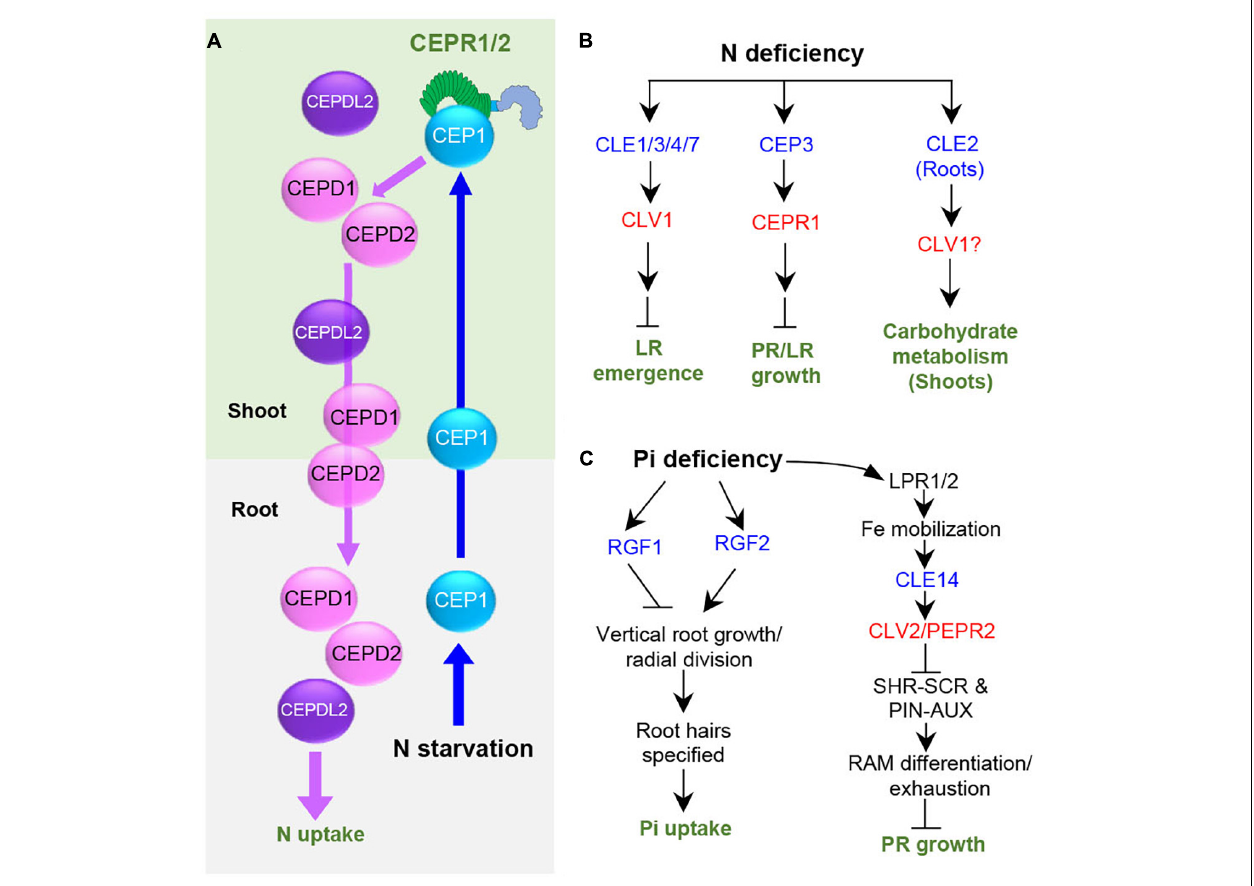
FIGURE 2 | Role and signaling pathways of peptides regulating plant responses under nutritional deficiency stresses in Arabidopsis. Blue and red letters indicate peptides and the cognate receptors, respectively. (A) The systemic N-acquisition response. (B) Plant responses under nitrogen deficiency. (C) Plant responses under phosphate deficiency. N, nitrogen; Pi, inorganic phosphate; LPR, Low Phosphate Root2; LR, lateral root; PR, primary